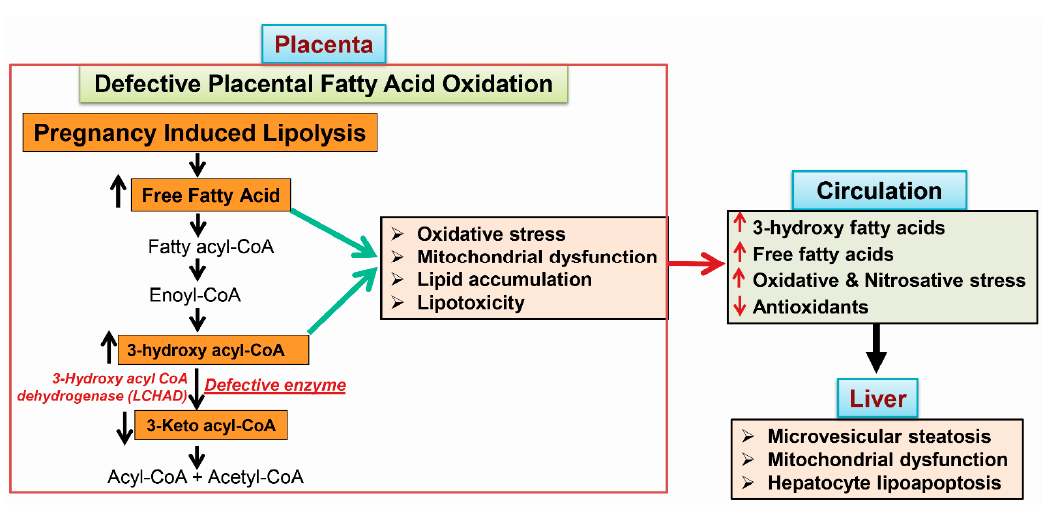
Figure 2. Schematic representation of the sequence of events that happen during acute fatty liver of pregnancy (AFLP). Fetal long chain 3-hydroxy acyl-CoA dehydrogenase (LCHAD) deficiency results in accumulation of 3-hydroxy fatty acids in the placenta, since the fetal part of placenta is identical to the genetic makeup of the fetus. Increased accumulation of placental free fatty acids and 3-hydroxy fatty acyl-CoA cause oxidative stress, mitochondrial dysfunction and placental lipotoxicity. Further, lipolysis induced in the third trimester of pregnancy would also trigger the accumulation of fatty acid intermediates, which are shunted from the placenta to the maternal circulation, where they can promote oxidative and nitrosative stress. These fatty acid intermediates reach the maternal liver resulting in microvesicular steatosis, hepatic mitochondrial dysfunction and hepatocyte lipoapoptosis.